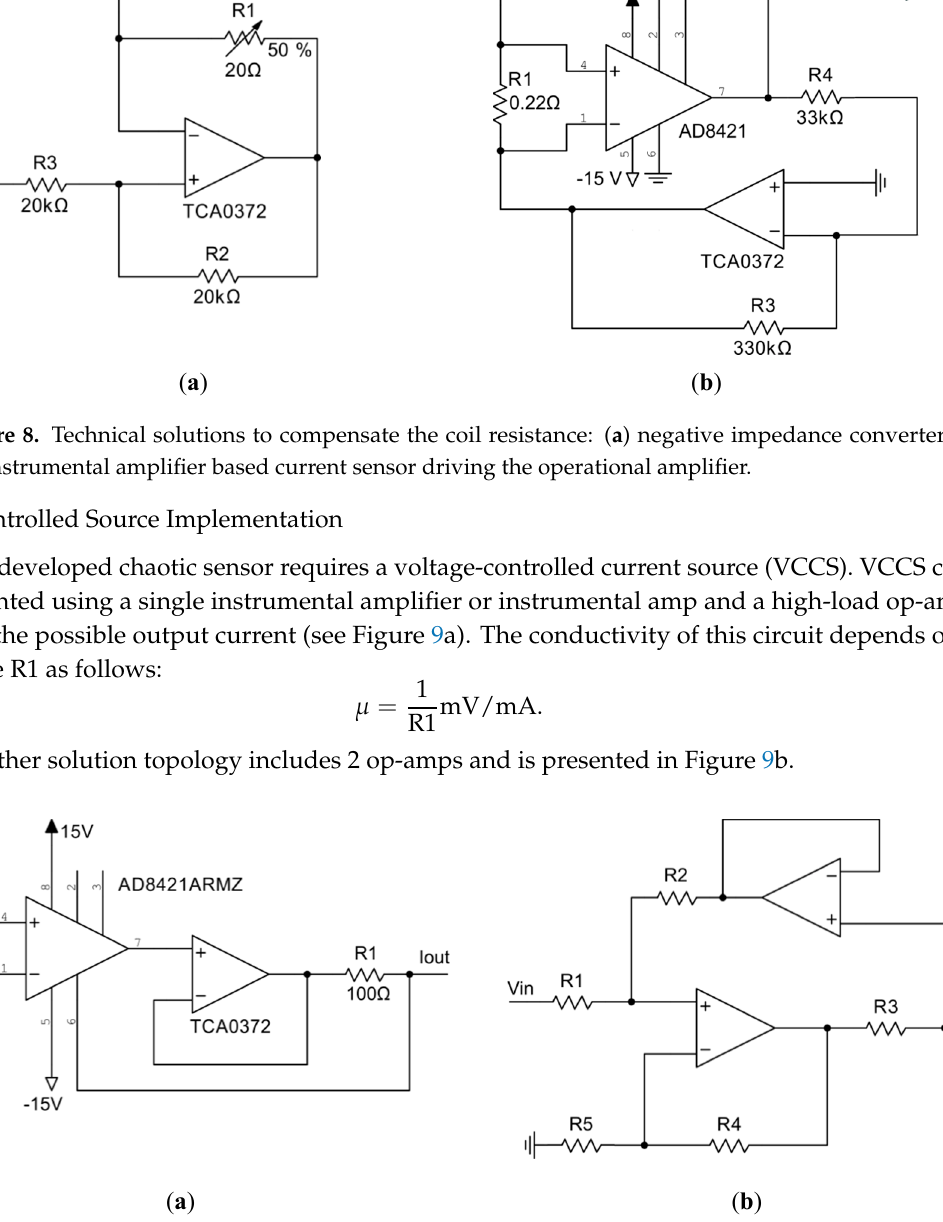
Figure 10. The analog circuit implementing the Sprott Case N chaotic oscillator with sensitive coil. 2.1.5. Influence of the voltage-controlled current source Due to the limits of physical implementation caused by finite supply voltage, the second nonlinearity is introduced by the VCCS in addition to the multiplication in the original ODE. This nonlinearity can be approximated using saturation as follows: 